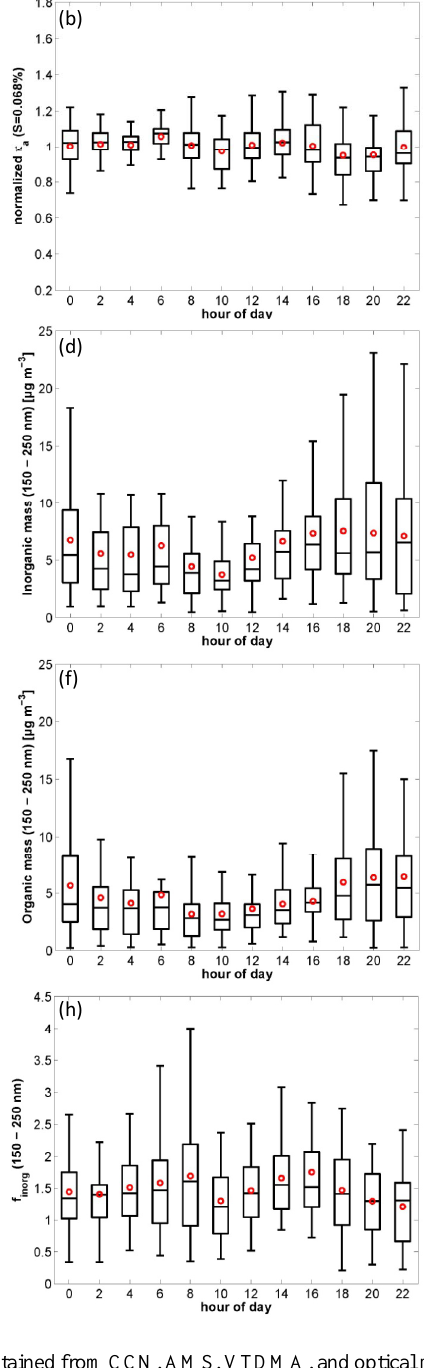
Fig. 12. Statistical distribution of diurnal cycles of several parameters obtained from CCN, AMS, VTDMA, and optical measurement results. The red dot is the mean value, the horizontal line in the box is the median, the limits of the boxes are the 25th and 75th percentile and the vertical lines extend to 5th and 95th percentiles. CCN derived parameters are plotted for higher (left panels) and/or lower (right panels) supersaturation corresponding to a smaller and larger particle size, respectively. The κ values are normalized by dividing the observed value by the daily average of that parameter. Mass concentrations and mass fractions are integrated from 50 to 70nm (left panels) and from 150 to 250nm (right